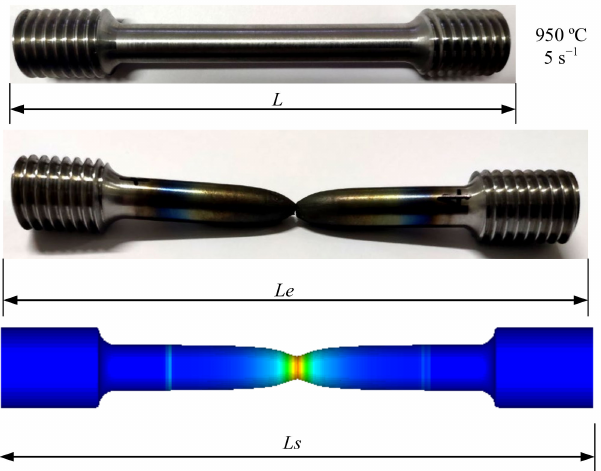
Figure 9. Comparison of simulated fracture displacement and experimental fracture displacement of the sample at 950 ◦ C/5 s − 1 .